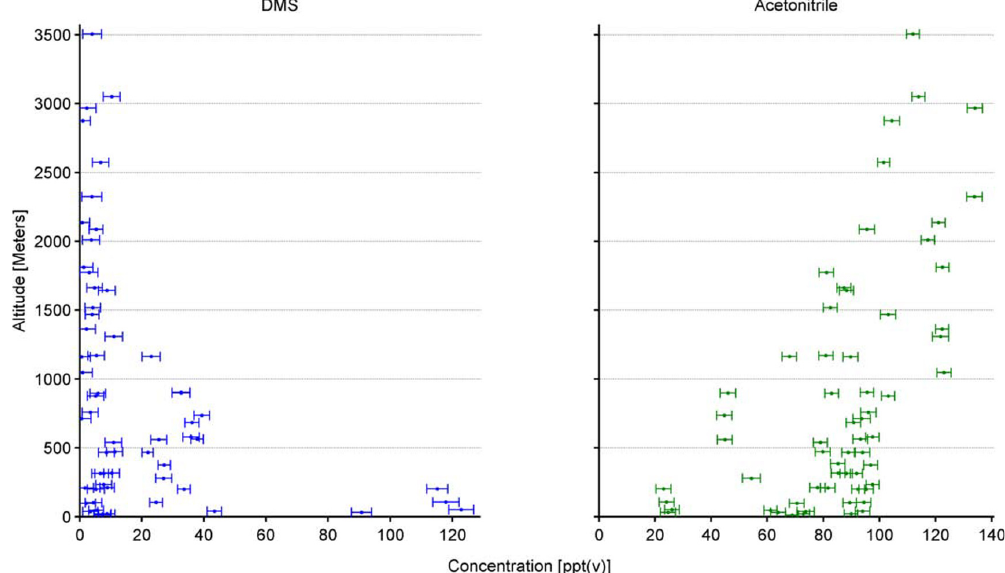
Fig. 8. Vertical dimethyl sulphide (DMS) and acetonitrile concentration profiles taken during eight flights carried out during the ice drift period of the ASCOS 2008 expedition. Blue and green points show DMS and acetonitrile concentrations respectively; error bars show the 95% confidence